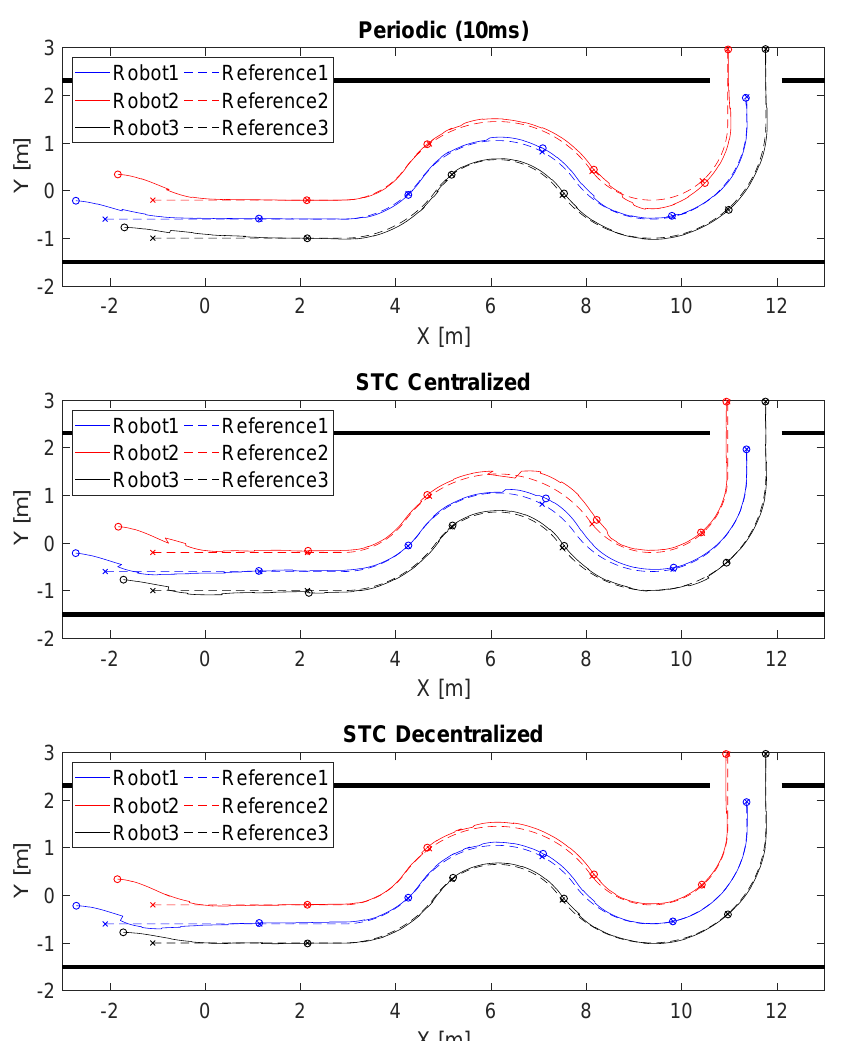
Figure 10. The nonlinear, trajectory tracking by the formation of three robotic units. Robot 1 is represented in blue, Robot 2 in red and Robot 3 in black, the route done by each robot is presented with a continuous line, the reference with a discontinuous line, and every 13 s the punctual position of each of them is shown with a circle and an x, respectively. The top figure represents the periodic implementation, the middle one the STC with centralized triggering (26) and the bottom the STC with decentralized triggering